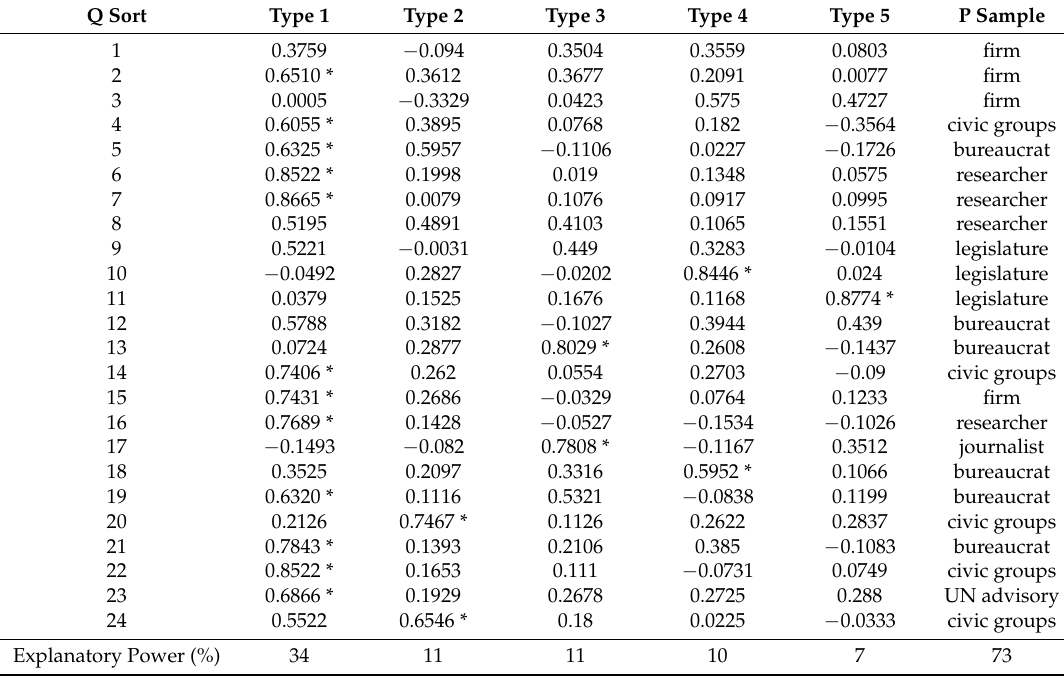
Table 4. Summary of Results for the Five Types Derived through PQMethod.